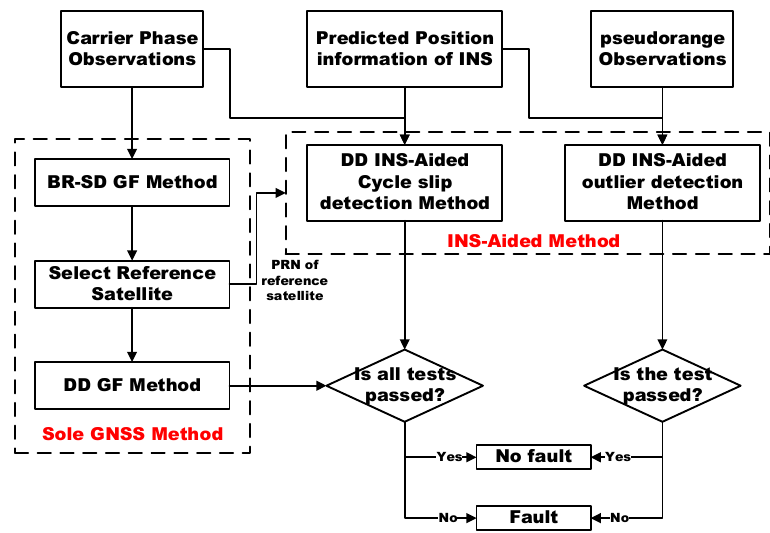
Figure 6. Dual-station fault detection flowchart.